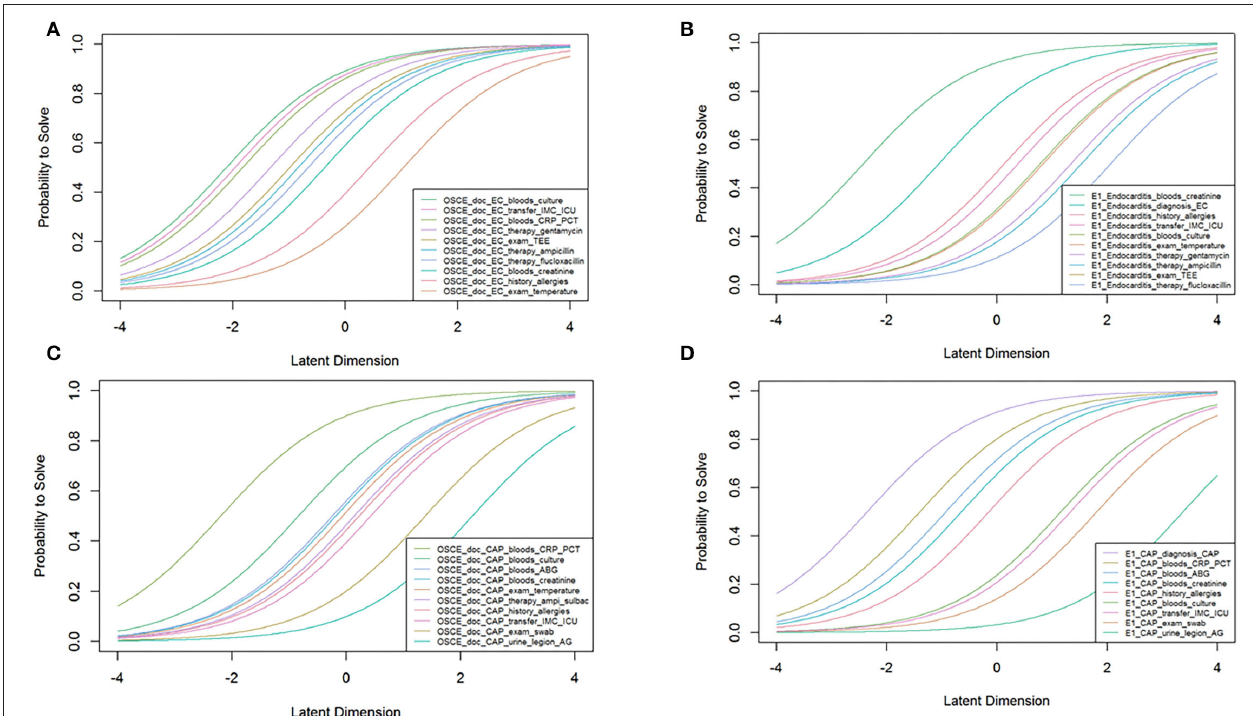
FIGURE 4 | Analyses according to Item Response Theory. Graphs indicate that the serious game is more suitable to differentiate between students within a given cohort, as those items cover a wider range of the underlying student ability. The further to the right on the X-axis the inflection point of the curve is located, the higher the person’s ability level must be in order to be able to solve the item with a 50 percent probability. (A) EC case (OSCE); (B) EC case (game); (C) CAP case (OSCE); (D) CAP case